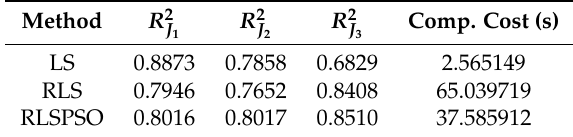
Table 3. Indexes R 2 (Joint 1, 2 and 3) and computational cost of algorithms.